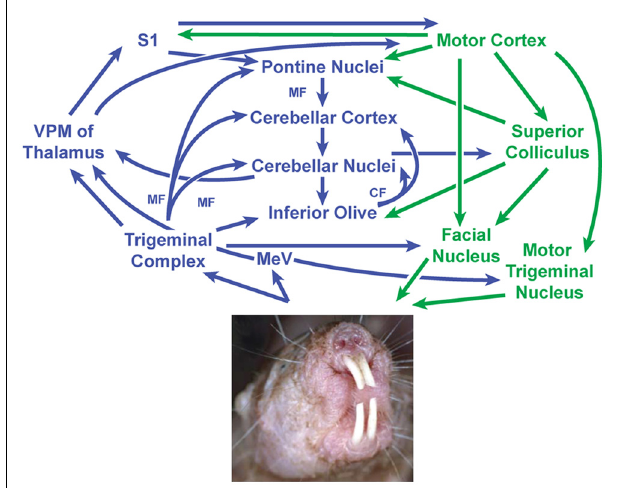
FIGURE 8 | Proposed circuit diagram for sensory inputs from the incisors (upper and lower) and motor output to the incisors (lower only), adapted from the neuronal pathways involved in sensorimotor transformations in rodent whisker movements (Bosman etal., 2010) combined with what is known about periodontal inputs in cats and ferrets (Cody etal., 1974; Linden, 1978; Gottlieb etal., 1984; Elias etal., 1987) .The cerebellum is centrally located within this network and receives both direct and indirect projections from the trigeminal nuclei.The mesencephalic nucleus is separated from the trigeminal nuclear complex in this diagram to emphasize what are thought to be very short latency projections from periodontal receptors to the cerebellum (Elias etal., 1987) along with projections from the mesencephalic nucleus mediating jaw reflexes via the motor trigeminal nucleus. Sensory stimuli – particularly from the incisors and mystacial vibrissae – are presumably integrated to guide and optimize motor outputs involving facial motor and trigeminal motor activity (in the naked mole-rat’s case, including movements of the lower incisors).This in turn would subserve the manipulation of objects and exploration of the subterranean environment. Image of naked mole-rat reprinted with permission from Elsevier, Copyright 2006. Catania, K.C., and Henry, E.C. (2006).Touching on somatosensory specializations